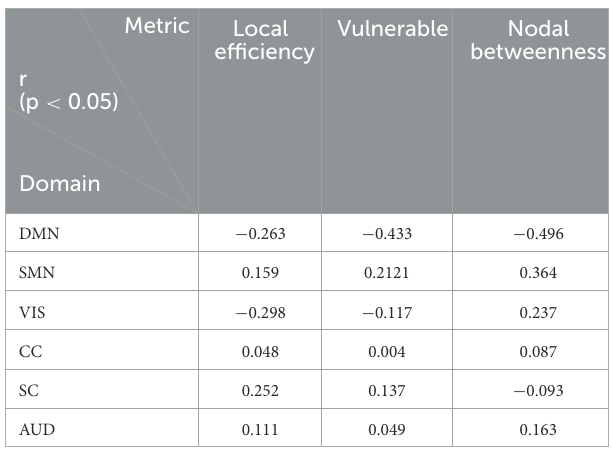
TABLE 3 The correlation between nodal graph measures and age.